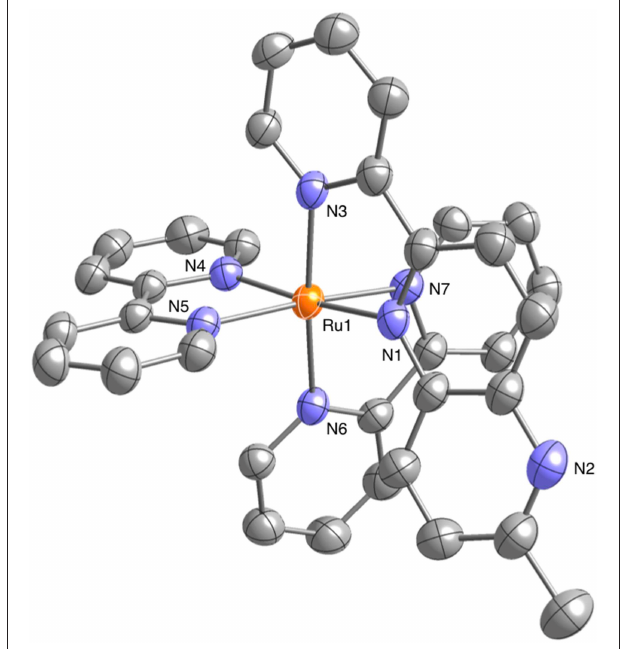
FIGURE 1 | Crystal structure of the ruthenium(II) NAD + -type complex [Ru(bpy)